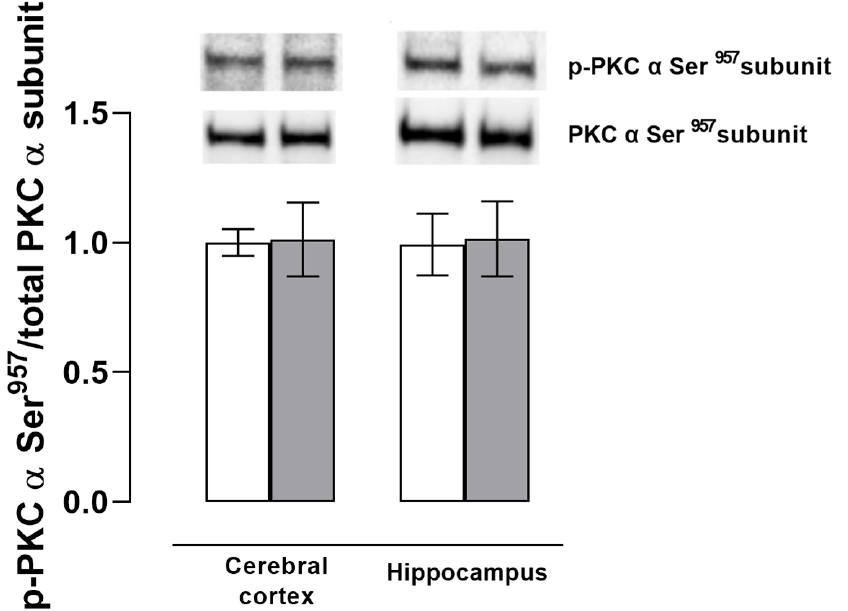
Figure 3. Effect of intermittent administration of AFB 1 (250 μ g/kg b.w., i.g.) or 2% DMSO (10 mL/kg b.w., i.g.) on the phosphorylation ratio of PKC in the cortex and hippocampus. Data are mean ± S.E.M. for n = four animals in each group. Statistical evaluation was performed by unpaired Student’s t test ( p >